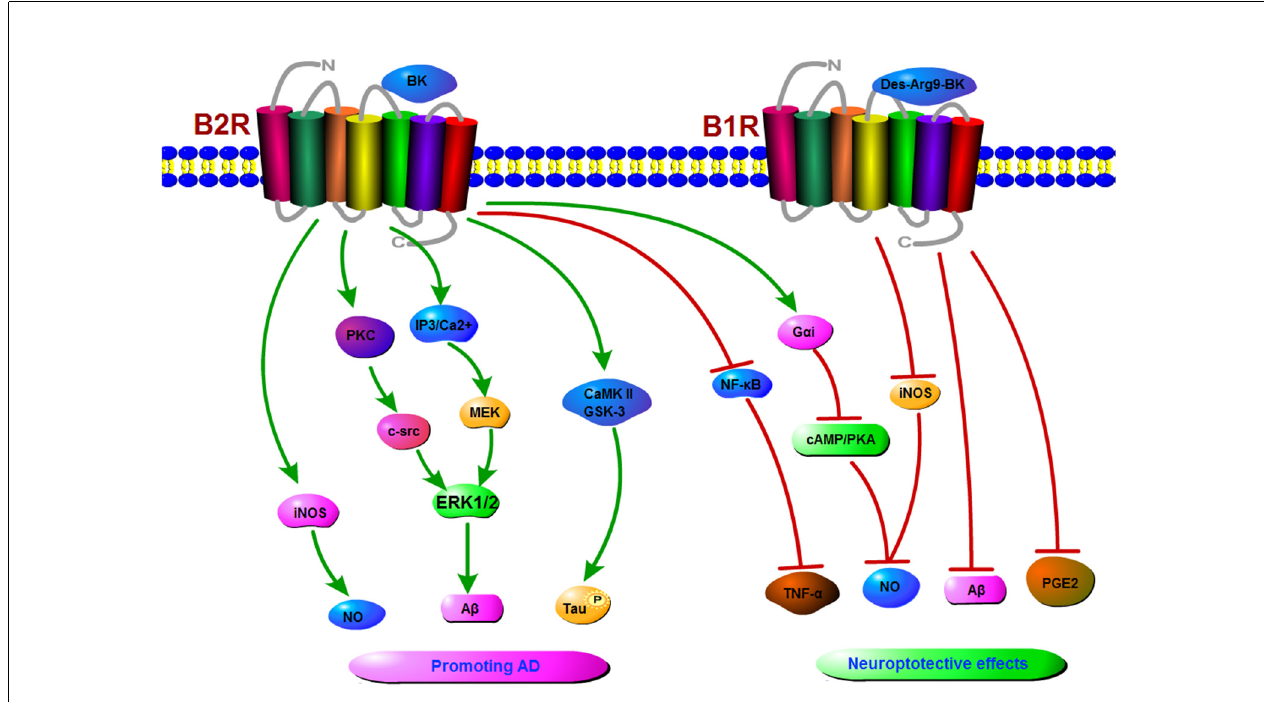
FIGURE 2 | A schematic diagram of signaling pathways mediated by the KKS in Alzheimer’s disease (AD). The binding of kinins to B1R or B2R induces the activation of protein kinase C (PKC), inducible nitric oxide synthase (iNOS), extracellular regulated protein kinases1/2 (ERK1/2), CaMKII, ultimately resulting in an increase in NO, tau phosphorylation, and amyloid β (A β ) production in AD. On the other hand, kinins receptors might play a neuroprotective role in AD by inhibiting the production of NO, A β , prostaglandin E2 (PGE2)